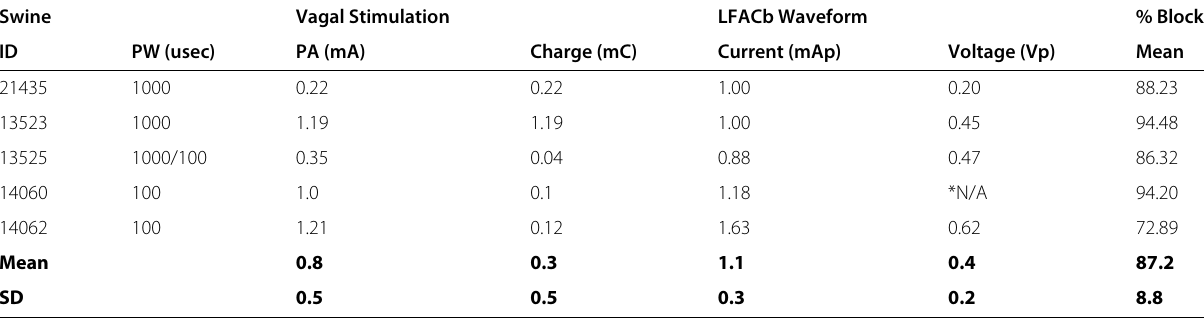
Table 1 Vagal stimulation and LFAC parameters used in the set of n=5 successful experiments. The LFAC waveform was strictly applied at 1 Hz . The average percent block amongst n = 5 experiment was calculated to be 87.2 ± 8.8 % ( ± SD). Two pulse widths, 1000 μ sec and 100 μ sec , were used for Swine ID 13525. The voltage drop across the blocking electrodes were within the Water window of the electrodes. *In one case, instrumentation issues did not allow for the retrieval of the LFAC voltage